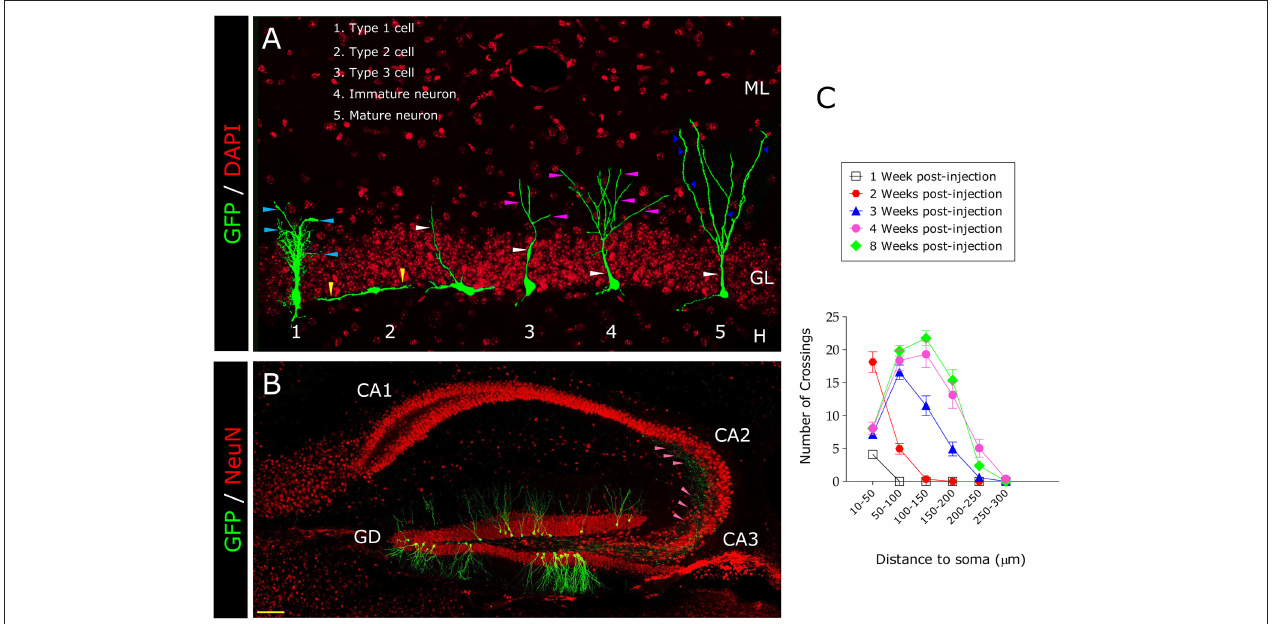
FIGURE 1 | Morphological maturation of newborn granule neurons under physiological conditions. In (A) the different morphological stages newborn neurons go through before becoming mature are shown. Type-1 cells have a triangular soma and a single apical prolongation that enters the granule cell layer, branching sparsely in the inner molecular layer, where it disperses into many small processes (pale blue triangles). Type-1 cells divide asymmetrically and give rise to transient amplifying progenitors. During their initial stages of differentiation, Type-2 cells have short processes oriented tangentially (yellow triangles) and an irregularly shaped dense nucleus. However, during more advanced stages of differentiation such as the neuroblast stage (Type-3 cells), the greatest morphological changes occur. At the end of this stage, cells are oriented vertically and present a rounded or slightly triangular nucleus and a clearly visible apical dendrite (white triangle). Immature newborn neurons sequentially increase the complexity of their dendritic trees (purple triangles) during subsequent maturational stages until they are indistinguishable from surrounding mature granule neurons. (B) Newborn neurons progressively enlarge their axons and send them toward the CA3 and the CA2 regions (pink triangles). In (C) the Sholl’s analysis of 1-, 2-, 3-, 4-, and 8-, week-old newborn granule neurons is shown. Dendritic branching progressively increases with age. The greatest morphological changes occur between 2 and 4 weeks post-injection. H, Hilus; GL, Granule cell layer; ML, Molecular layer. Yellow scale bar: 100 µ m. Dark blue triangles, Dendritic